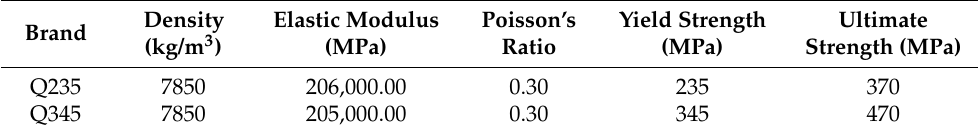
Table 2. Physical and mechanical property parameters of